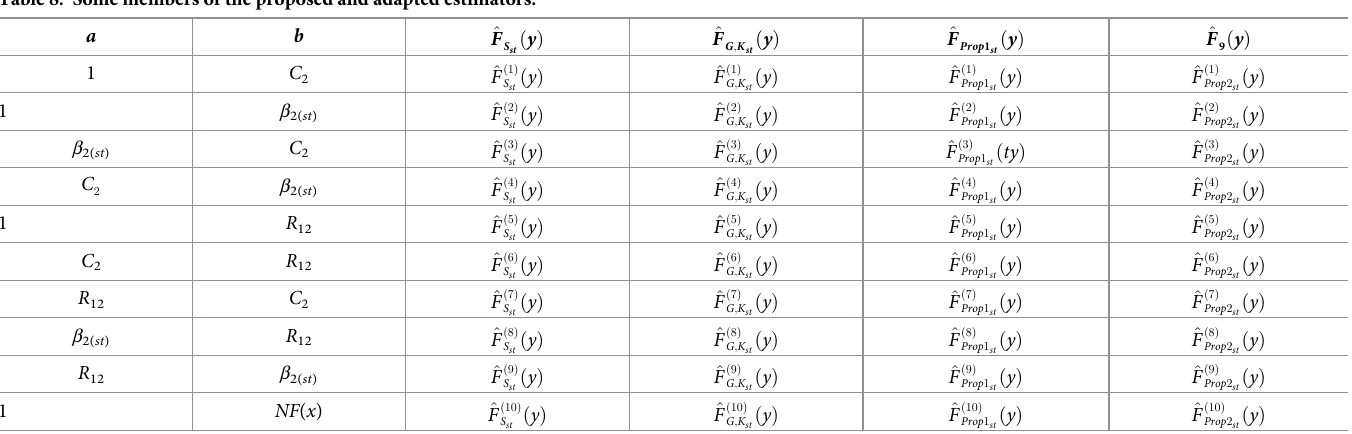
Table 8. Some members of the proposed and adapted estimators.